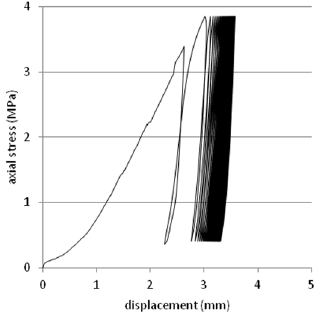
Figure 12. Plot of cCBR test results for steel slag after 50 cycles of loading (unsoaked